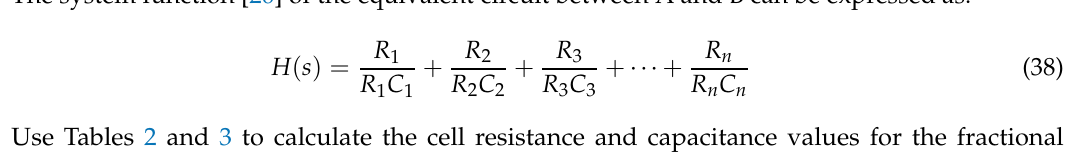
s q . (cid:3046) (cid:3292)